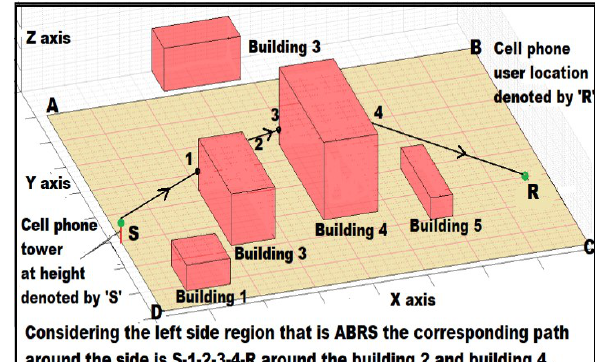
Figure 8. A signal path around the left side of the building